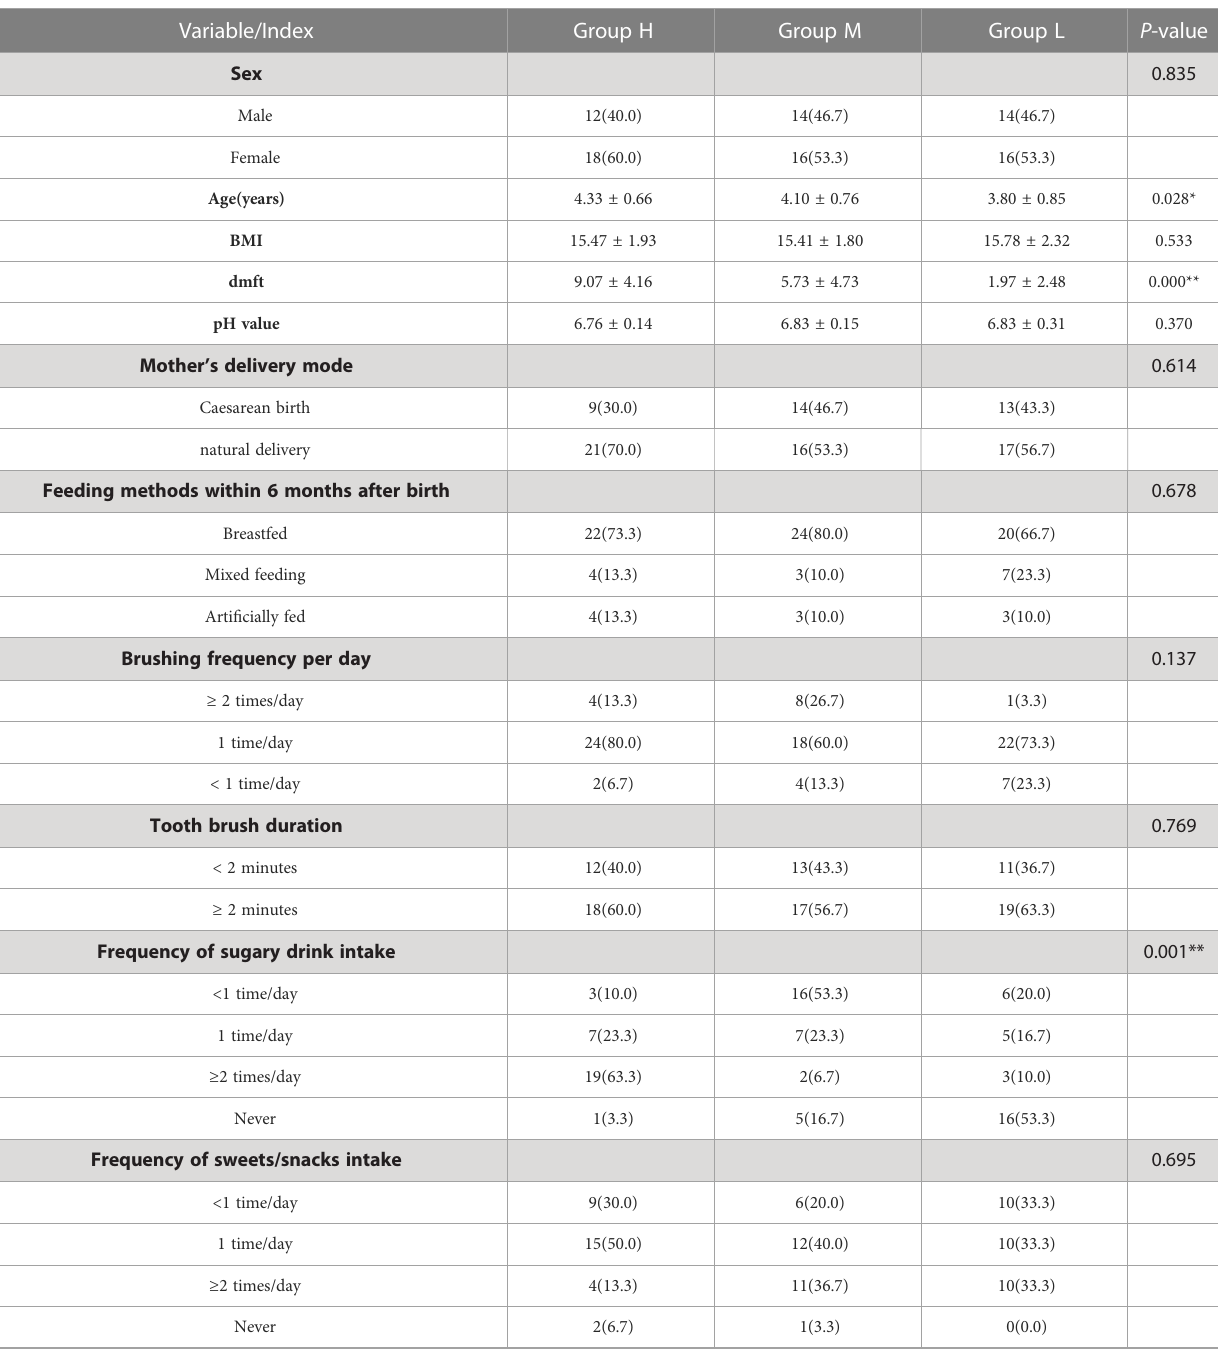
TABLE 1 Demographics of study population and analysis of related in fl uencing factors of high